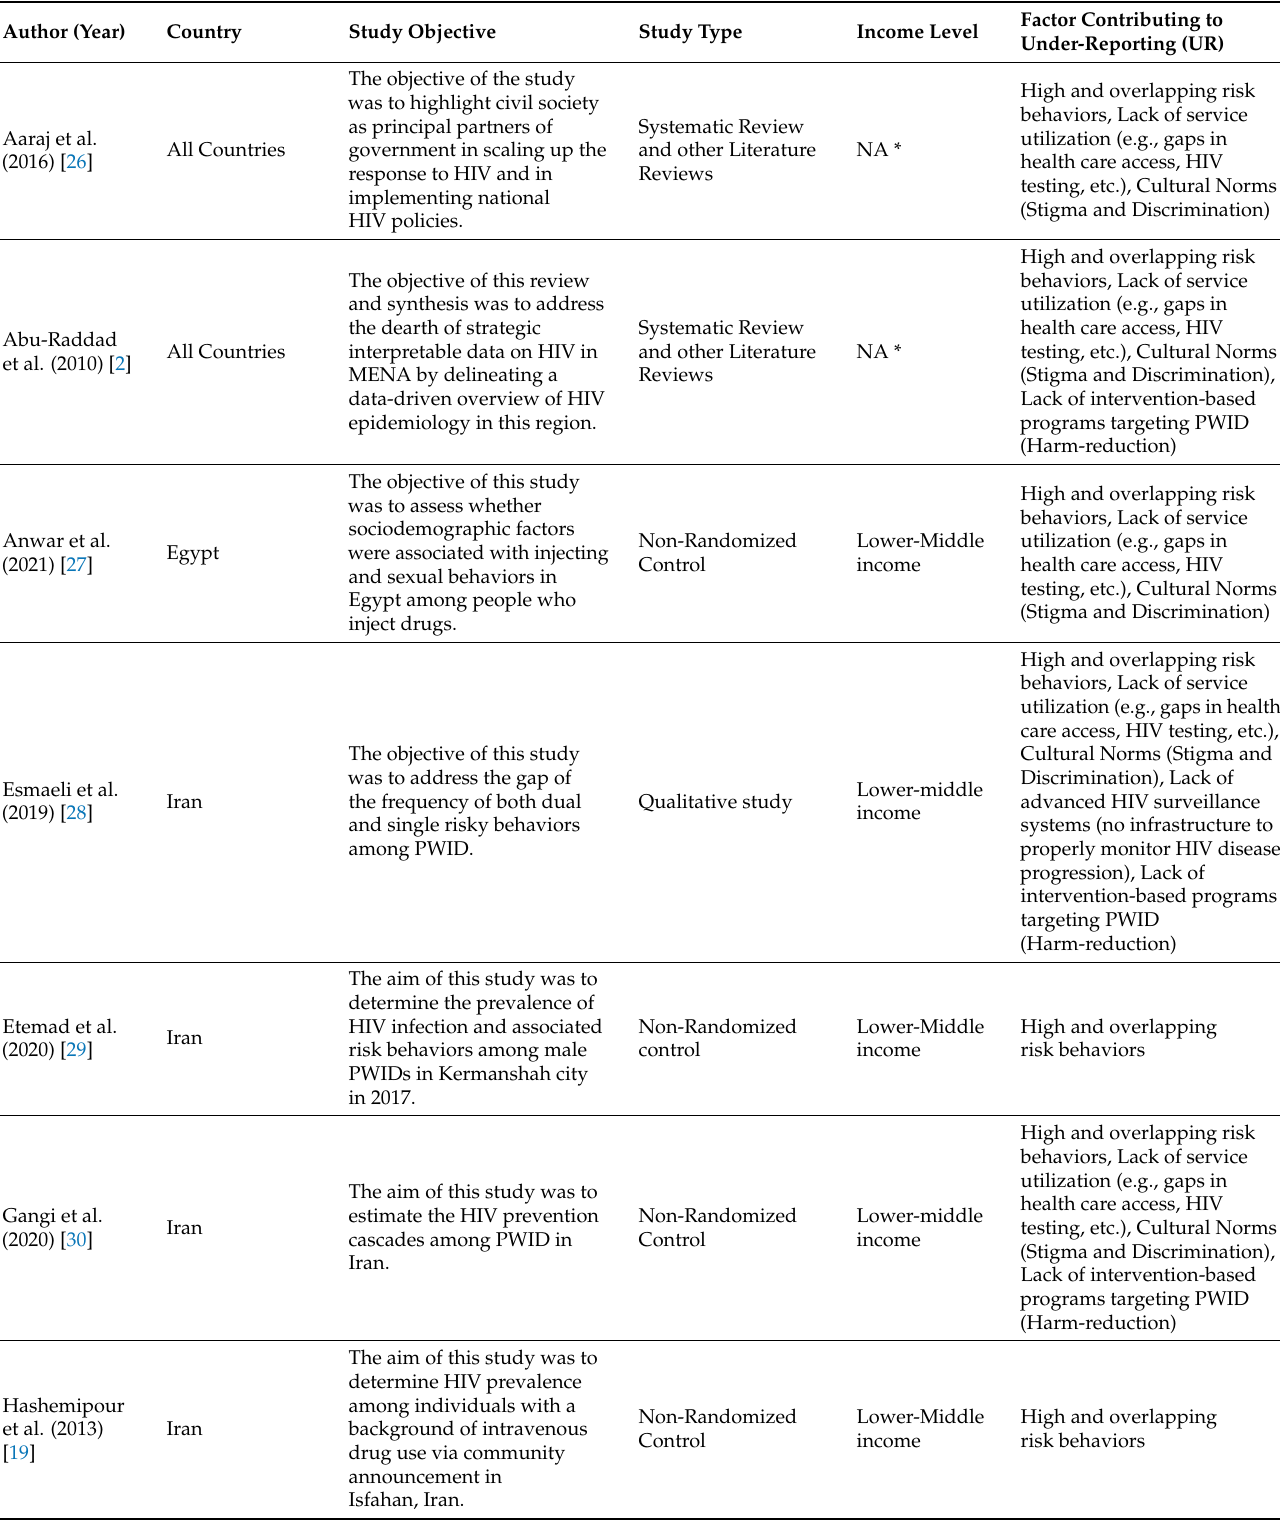
Table 1. List of included studies attained from the assessment and screening